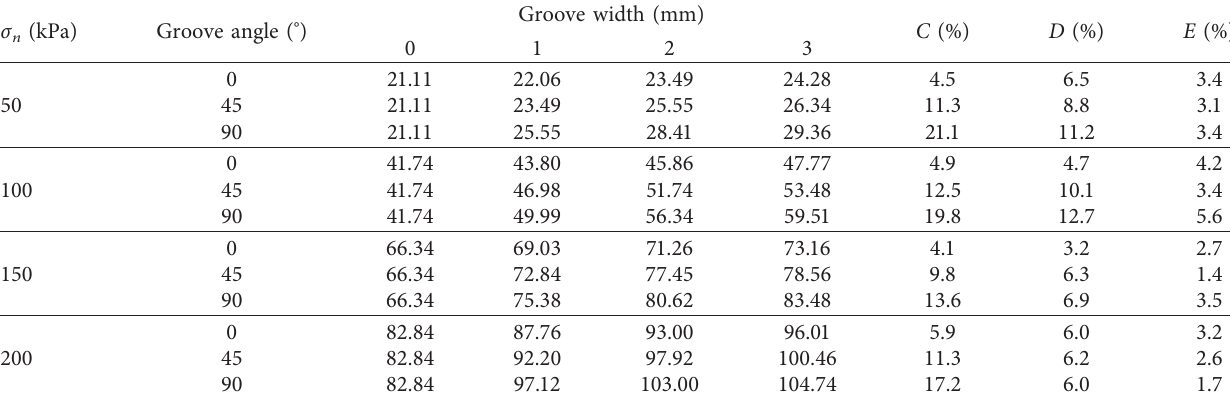
Table 3: Increasing extent of peak shear stress with groove